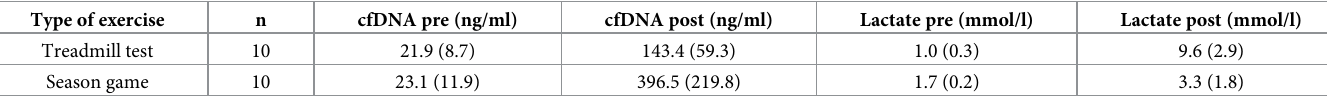
Table 2. Comparison of cfDNA and lactate after treadmill test and season game.